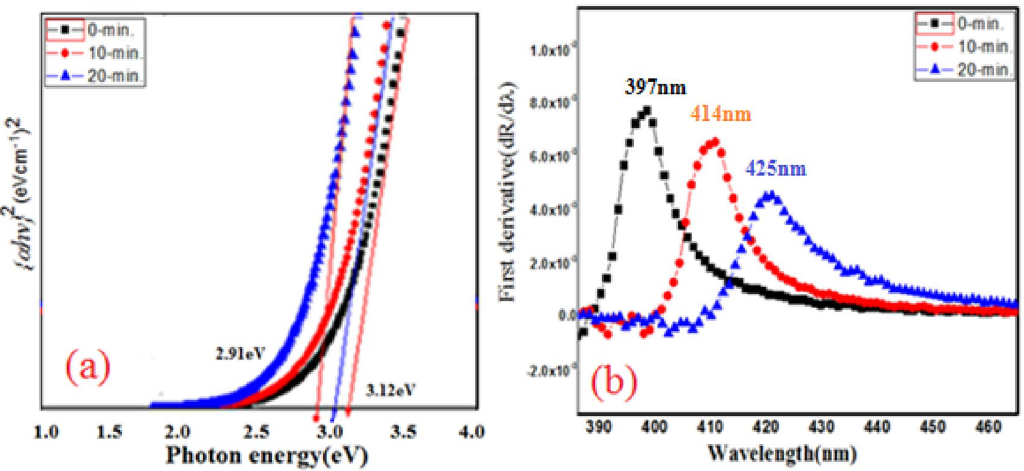
Figure 4. ( a ) Tauc plot for energy bad gap determination and ( b ) First derivative plots of Reflectance of as-grown and irradiated ZnO-CdO coated films.